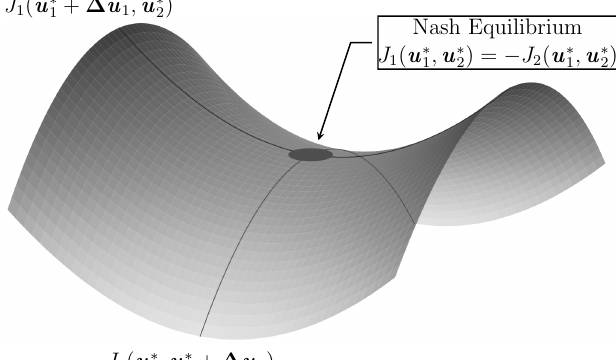
Figure 2. The figure illustrates a Nash equilibrium in a two-player zero-sum game. The protagonist J 1 ( u 1 , u 2 ) while the adversary counteracts through maximization minimizes the objective min u 1 J 2 ( u 1 , u 2 ) . In this equilibrium, each player achieves an optimal payoff when following the max u 2 ) . (i) In case 1, the protagonist deviates from the optimal action with ∆ u optimal action ( u ∗ , u ∗ 2 1 The adversary pursues the optimal action. Consequently, the protagonist gets a higher payoff. The adversary, on the other hand, reaches a better objective. (ii) In case 2, the protagonist follows the optimal action. However, the adversary changes his action by ∆ u 2 . As a result, the protagonist achieves better outcomes—the opponent’s outcomes decrease. Therefore, the Nash equilibrium corresponds to a solution in which both players achieve the best possible outcome w.r.t. each other. A change in the policy causes a loss and should be avoided.